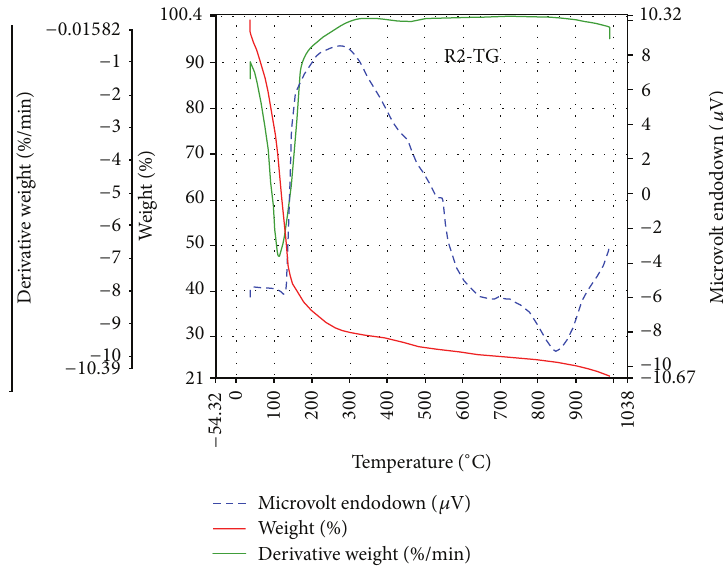
Figure 1: TGA curve of complex [ { ( o- CH 3 C 6 H 4 O) 2 PS 2 } 2 Mn] ( 1 ).